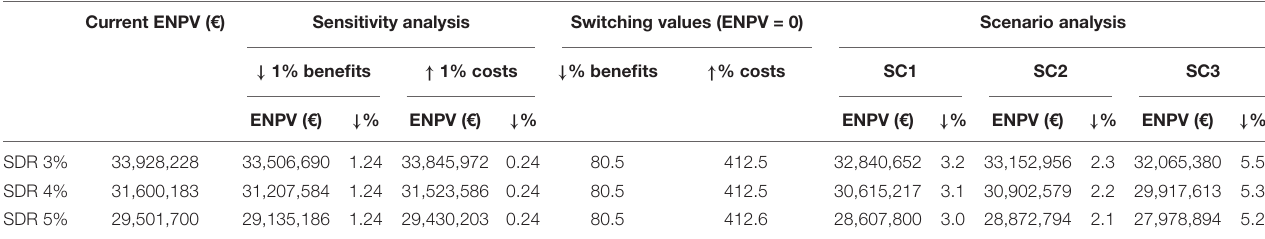
TABLE 5 | Results of the cost-benefit analysis performed for 2016–2030. Current ENPV (€) Sensitivity analysis Switching values (ENPV = 0) Scenario